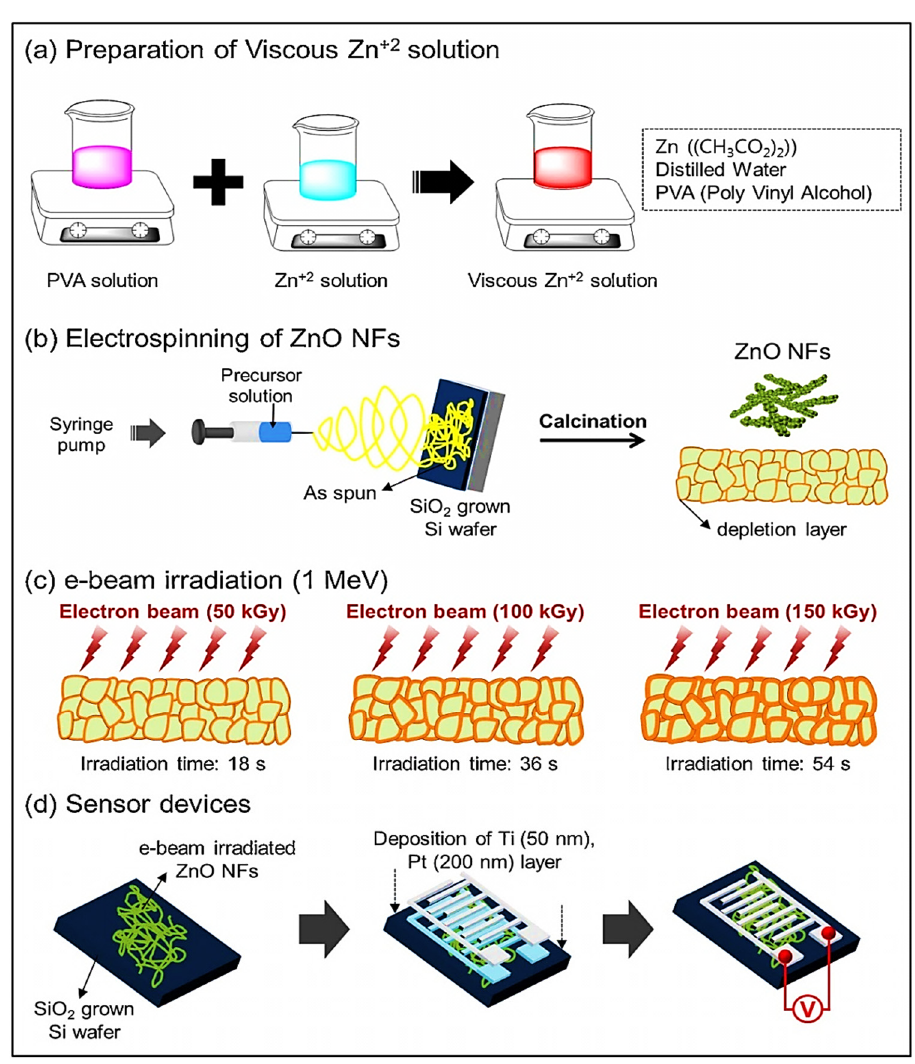
Figure 25. Illustration of ( a – b ) the synthesis of ZnO NFs, ( c ) e-beam irradiation, and ( d ) sensor fabrication. Reproduced from [127] with the permission of Elsevier.